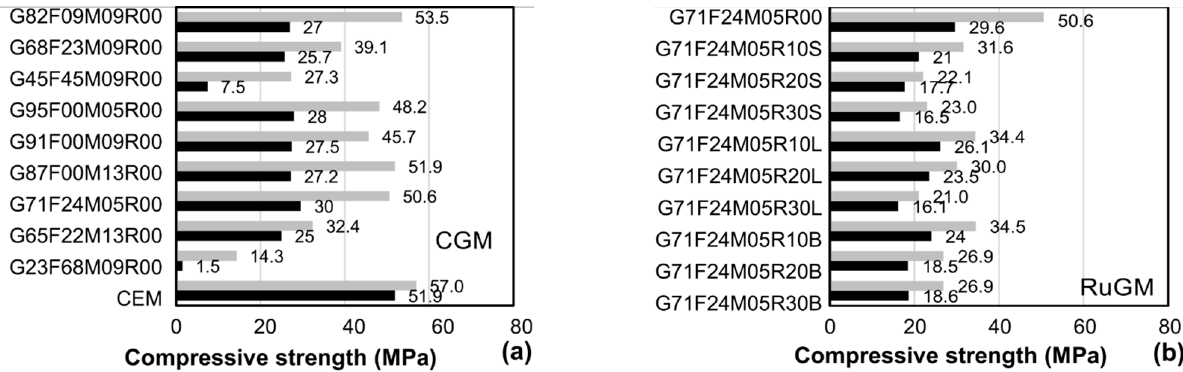
Figure 5. Compressive strength results for: ( a ) CGM, ( b ) RuGM (note: black bars represent the compressive strength at 7 days, whilst the grey bars represent the compressive strength at 28 days).